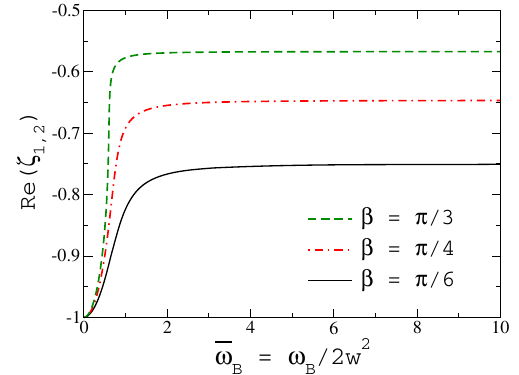
Fig. 3 Therealpartofthetwocomplexrootsofthecubicequation(65) as a function of the reduced frequency ¯ ω B for particular values of the angle β